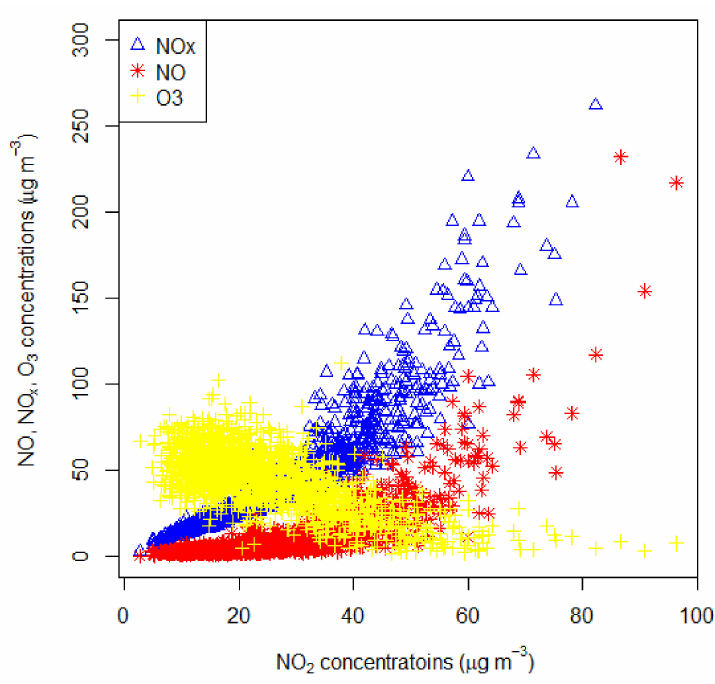
Figure 16. Scatter plot showing the association of NO 2 with NO, NOx and O 3 concentrations ( µ g/m 3 ) at the Devonshire Green AQMS in